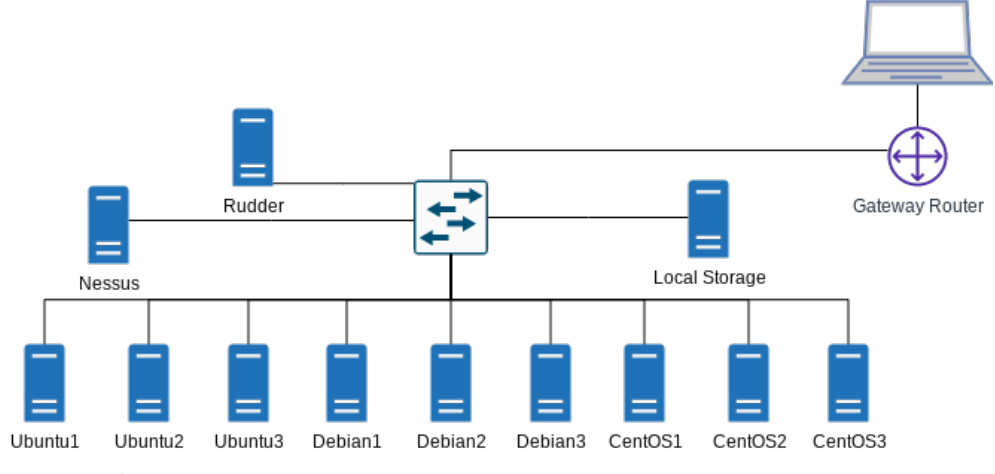
Figure 6. The test environments Table 5. The specifications for the virtual servers in the test